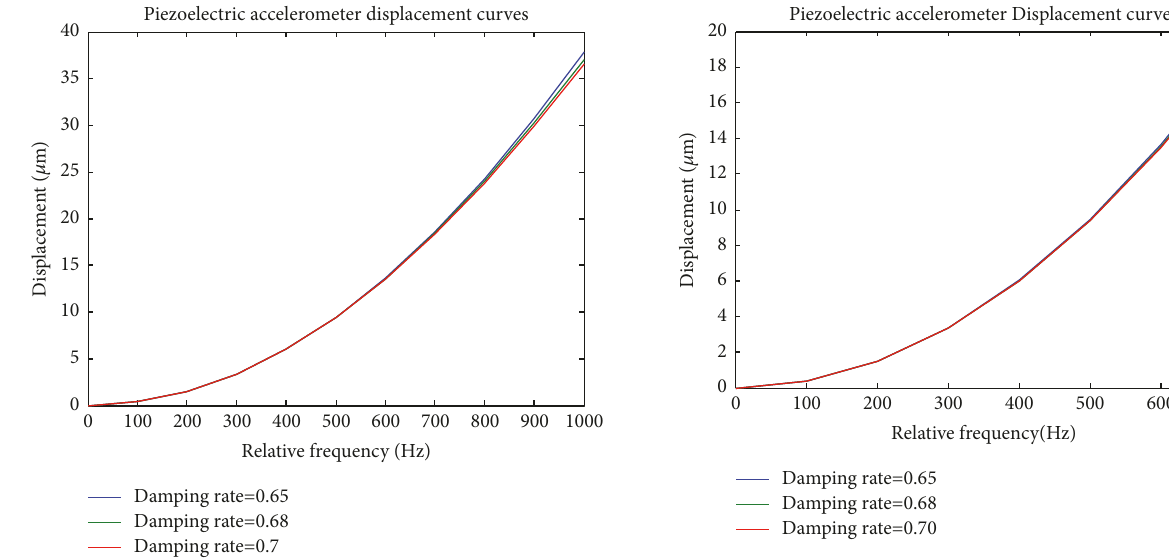
Figure 10: Displacement as a function of relative frequency for three values of damping rate in the case where the relative frequency is varied from 0 to 750Hz.